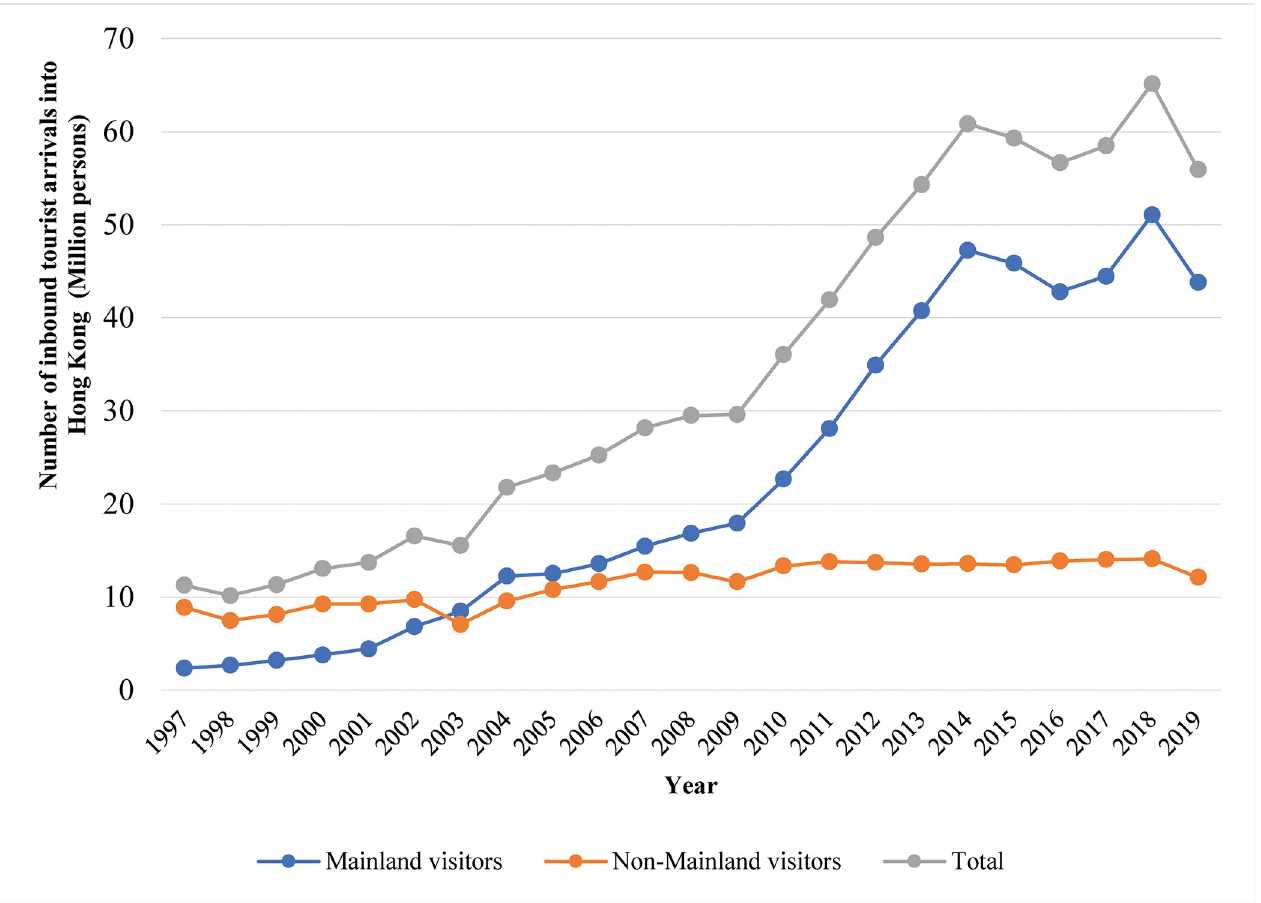
Fig 3. The number of inbound tourism arrivals into Hong Kong, 1997–2019. Data source: Hong Kong Annual Digest of Statistics. https://www.censtatd.gov.